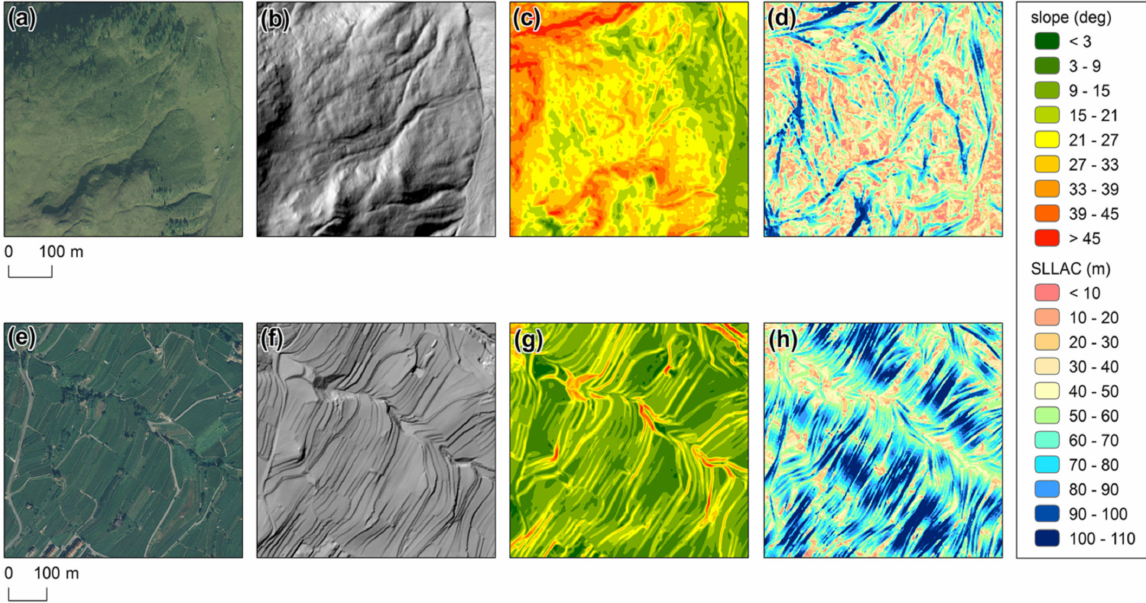
Figure 15. By comparing evolutionary and anthropogenically induced geomorphic structures and structural forms, conclusions can be drawn about the degree of anthropogenic overprinting. The anthropogenic fingerprint on geomorphology can be derived using RS technologies. “Images il- lustrating the detection of the anthropogenic topographic signature of terraced landforms in the Alpine context (Trento Province, central Italian Alps, Italy). Images of natural ( a – d ) and terraced landscapes ( e – h ) are derived from aerial photographs ( a , e ); shaded relief maps are derived from 2 m LiDAR digital terrain models (DTMs) ( b , f ); slope maps ( c , g ); and maps of the slope local length of auto-correlation (SLLAC) ( d , h ). The LiDAR dataset is offered as a free download by the Autonomous Province of Trento (Alps). Natural landscapes show maps of SLLAC with randomly distributed ele- ments and highly noisy backgrounds, whereas the construction of terraces yields a clear topographic signature that results in more regular SLLAC maps, with ordered elongated elements that follow the terrace benches” (from Braun et al.